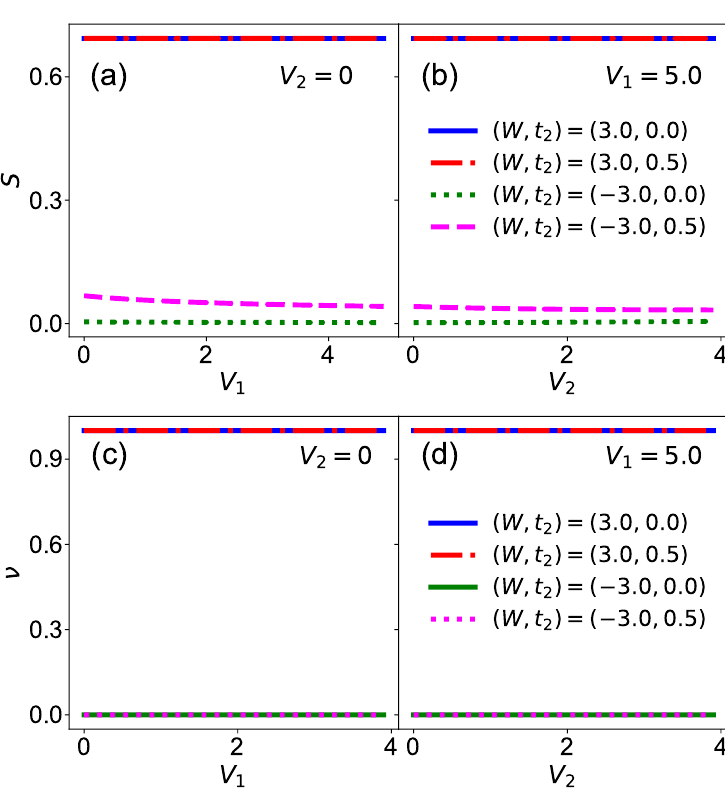
= 0; Figure 7: Entanglement entropy S as a function of : (a) NN repulsion V with V 1 2 = 5.0, both measured under OBC. The measure- and, (b) NNN repulsion V with V 2 1 ) values detailed in the legend ments are performed for four different sets of ( W , t 2 = 0; and, (d) with N = 400. Zak phase as a function of (c) NN repulsion V with V 1 2 = 5.0, measured for a ladder with N = 8 for four different NNN repulsion V with V 2 1 ) sets of ( W , t 2